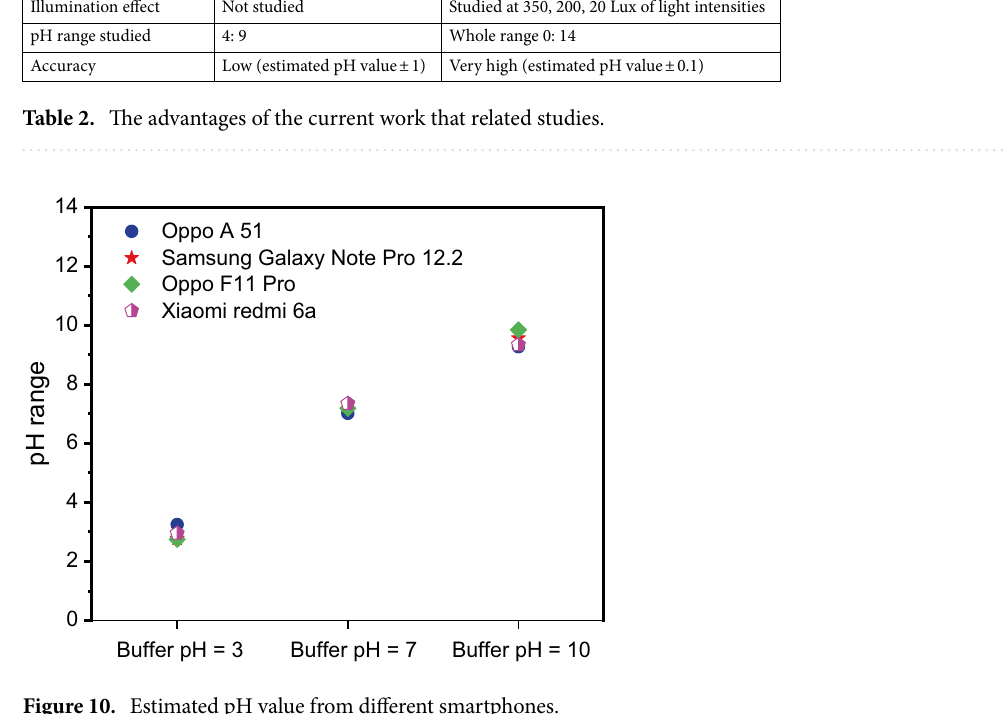
Figure 10. Estimated pH value from different